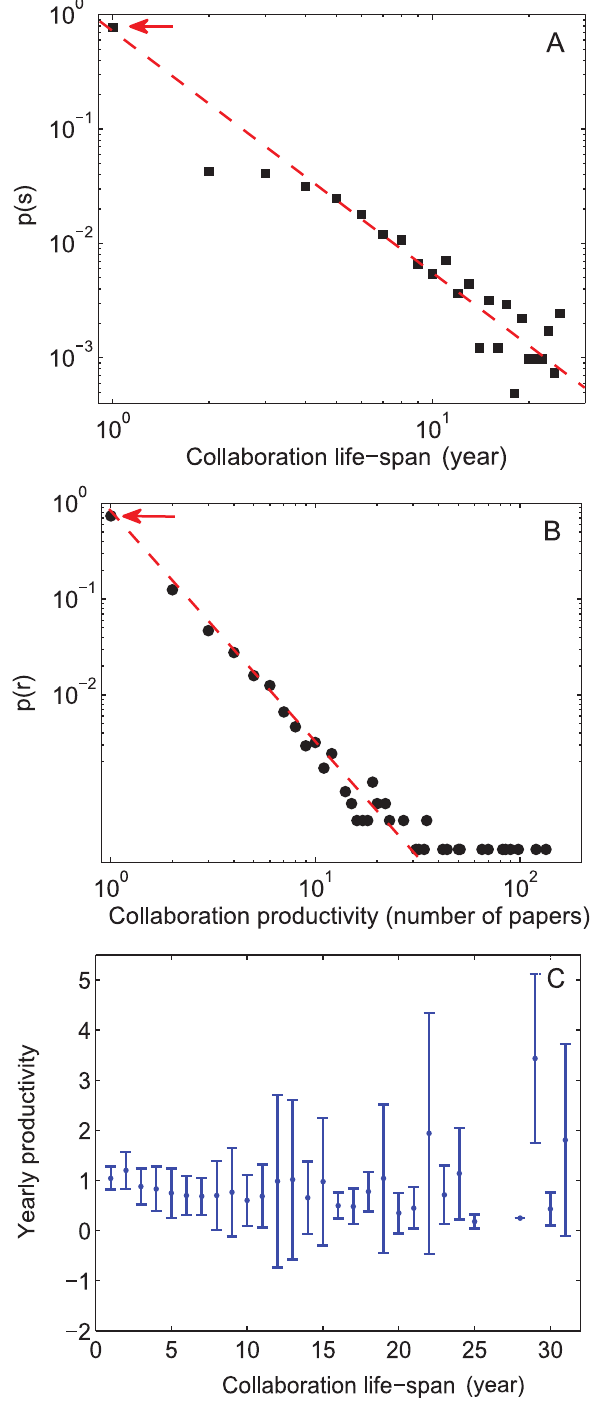
Figure 1. Statistics of scientific collaboration life span and productivity. (A) The probability distribution p ( s ) of collaboration life span s . Most collaborations lasts for only one year. The dashed line is a power law with exponent 2 2.3. (B) The probability distribution p ( r ) of number of journal articles r published by each collaboration. The dashed line is a power law with exponent 2 2.4. (C) Average yearly productivity for collaboration of different life spans. The average publications produced by each pair in a collaboration stays a bit lower than 1 per year, whereas for collaborations with longer life spans, the productivity